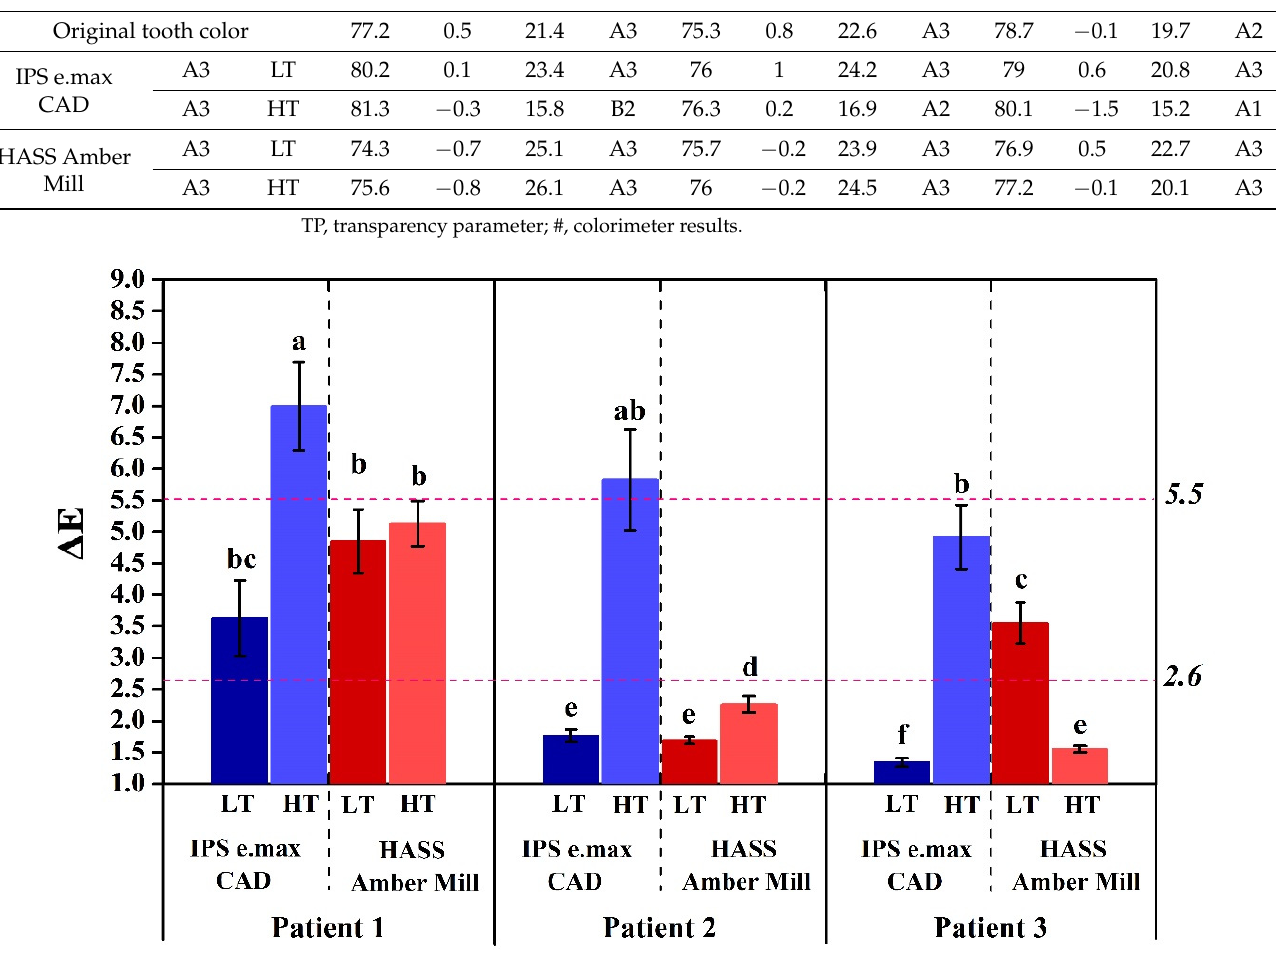
Figure 12. Color difference ( ∆ E) values of A3 color glass-ceramics placed in the human oral cavity. Means with different letters differ significantly ( p < 0.05, mean ± SD, n = 3).